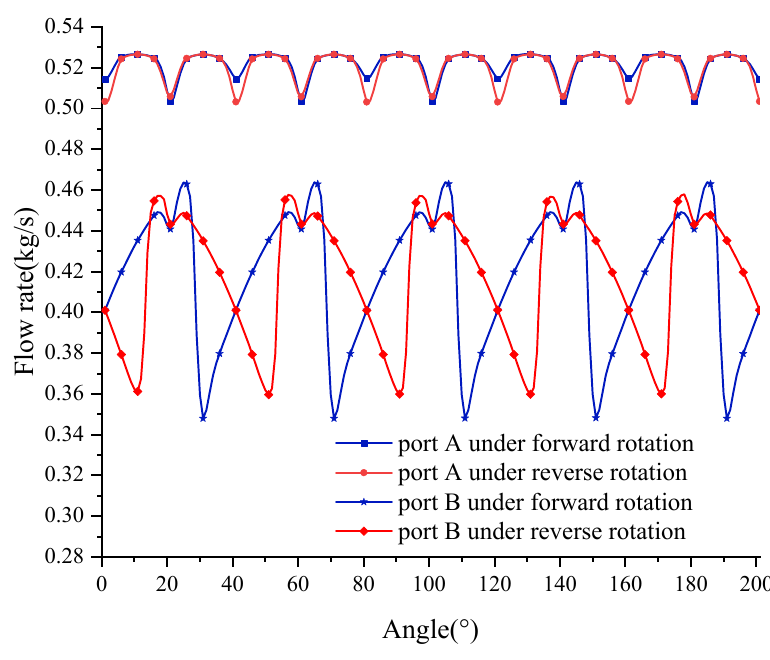
Figure 11. Flow rate under forward and reverse rotation of ports A and B.